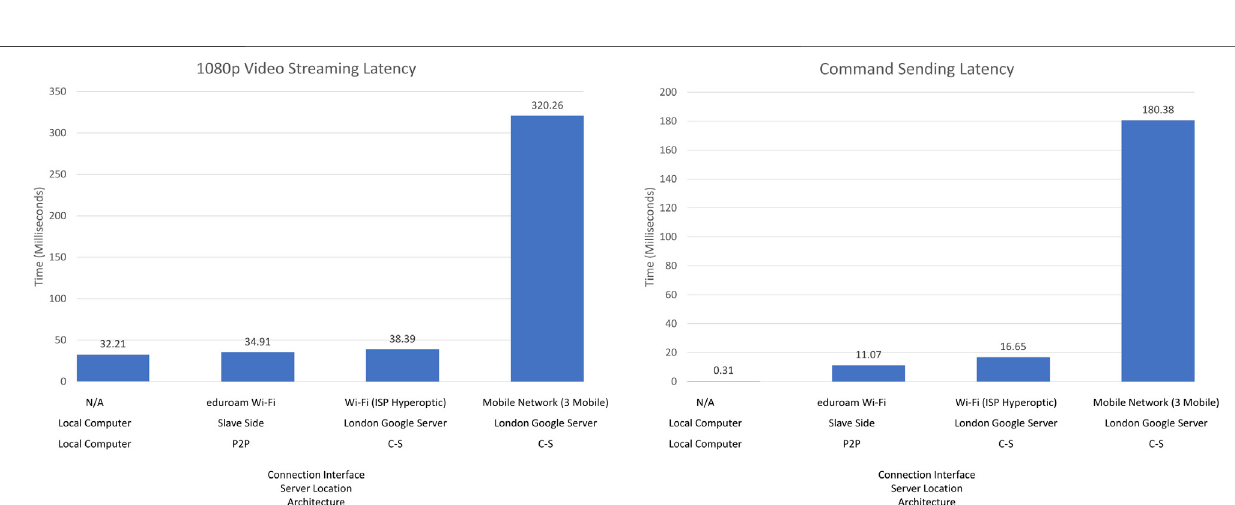
FIGURE 13 | Command sending latency (left) and Video Streaming latency